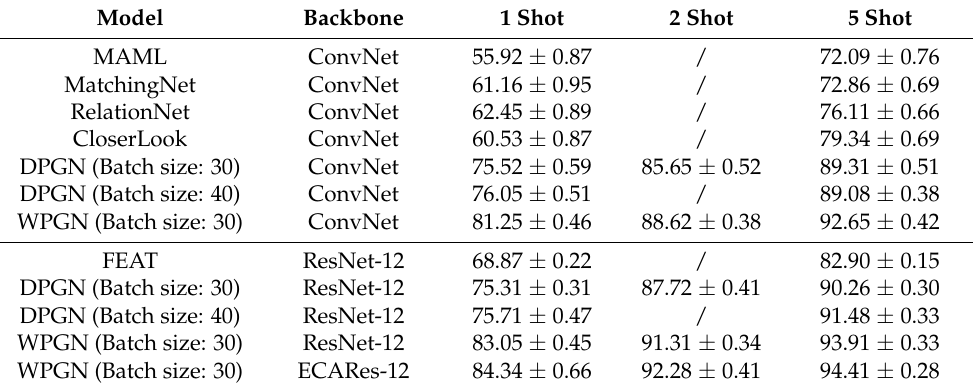
Table 7. Few-shot classification accuracies on CUB-200-2011.